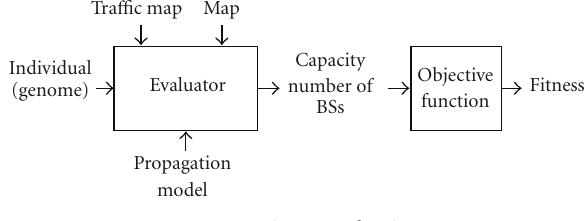
Figure 4: Fitness